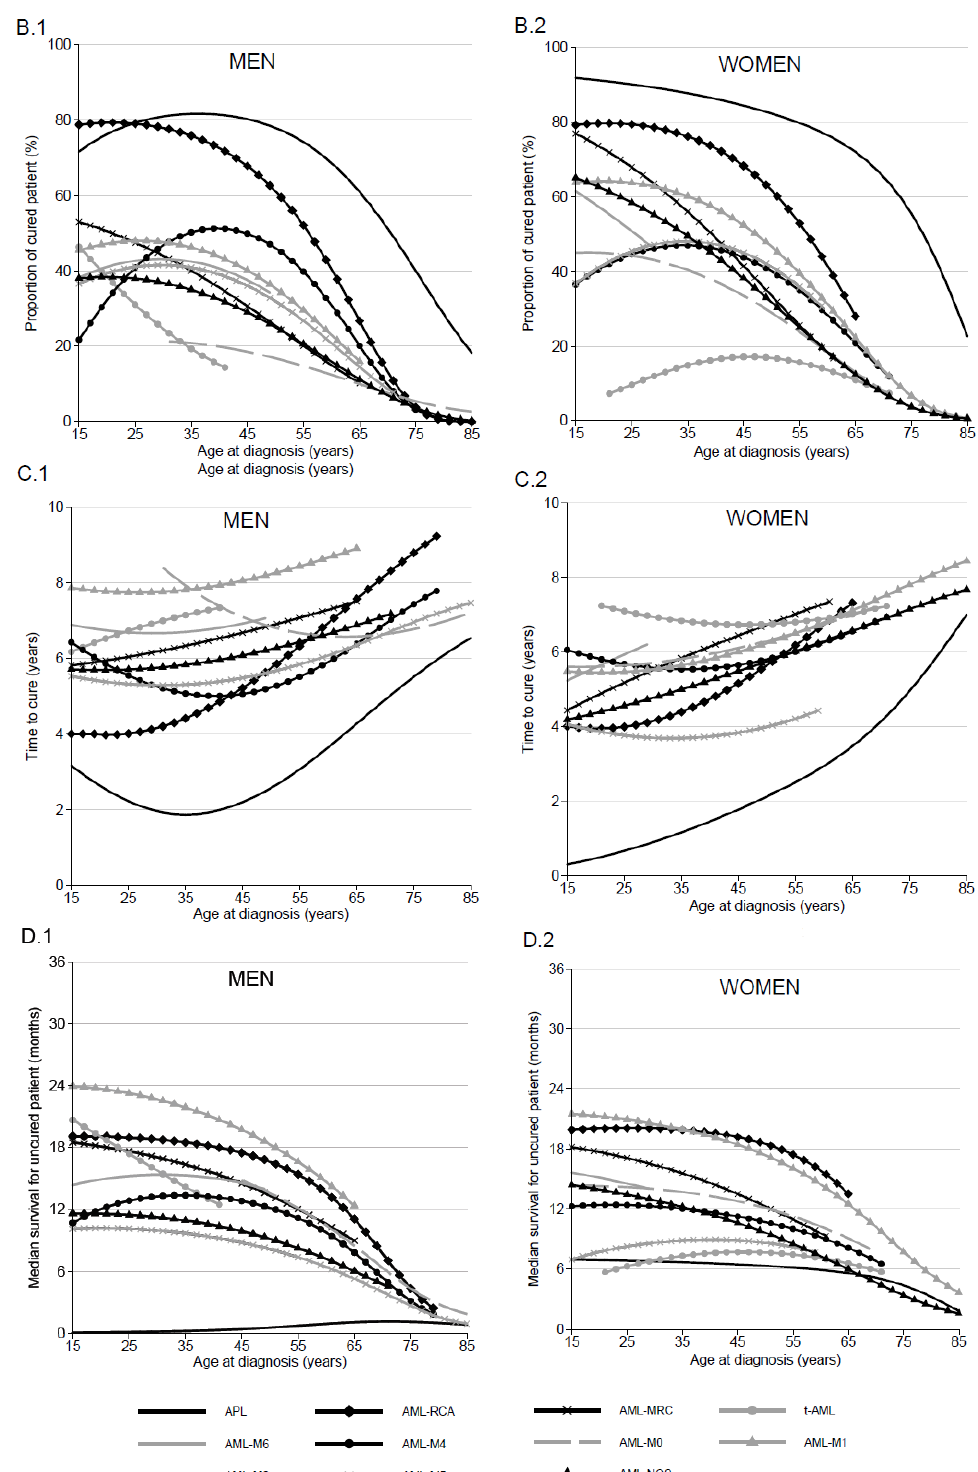
Figure 2. Excess mortality rate and cure indicators for patient diagnosed from 1995 to 2015 according to AML subtype and sex: Excess mortality rate (deaths per person-year) over the age at diagnosis in years in men ( A.1 ) and in women ( A.2 ); reference horizontal line at the excess mortality rate equal to 0.05 to fix the limit of the cure assumption accepted. Proportion of “cured” patients over the age at diagnosis in men ( B.1 ) and in women ( B.2 ). Time to cure over the age at diagnosis in men ( C.1 ) and in women ( C.2 ). Median survival time for “uncured” patients in months over the age at diagnosis in men ( D.1 ) and in women ( D.2